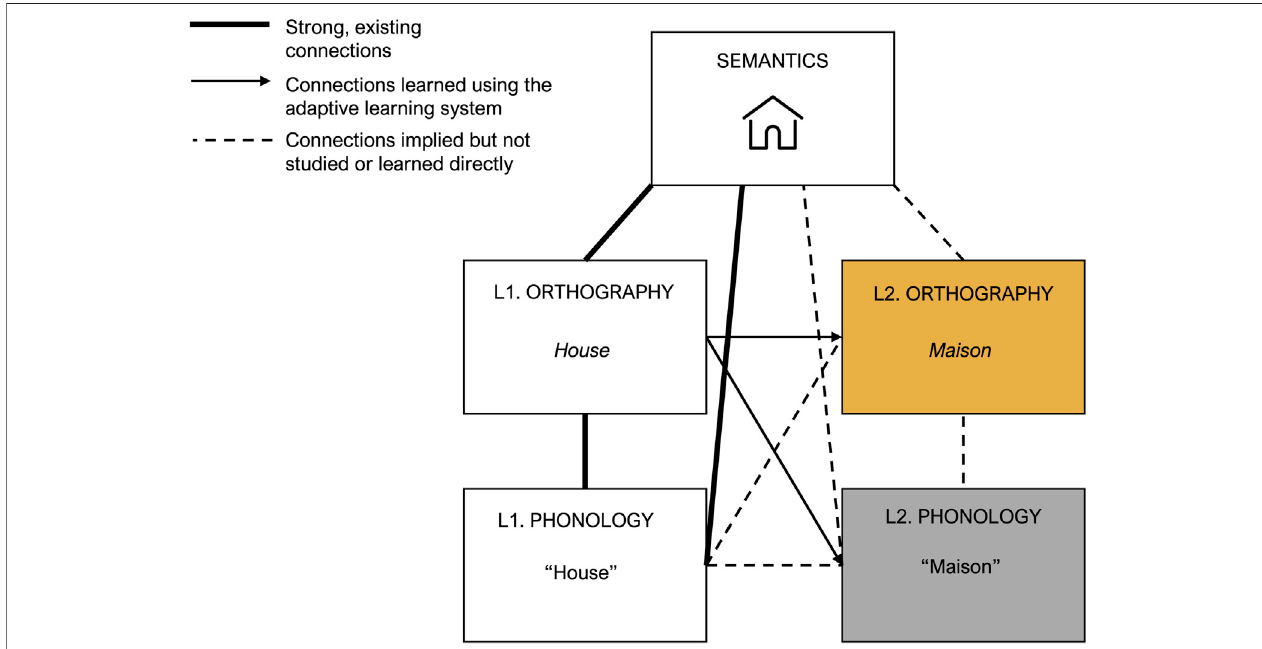
FIGURE 1 | Theoretical framework for typing- and speech based vocabulary learning. Thick solid lines represent strong, established connections between fi rst languagerepresentationsforawordinthementallexicon.ArrowsrepresentthenewlylearnedconnectionsbetweenL1orthographicandL2orthographic(typing-based learning) or L2 phonological (speech-based learning) representations. Dotted lines represent connections that are learned implicitly.